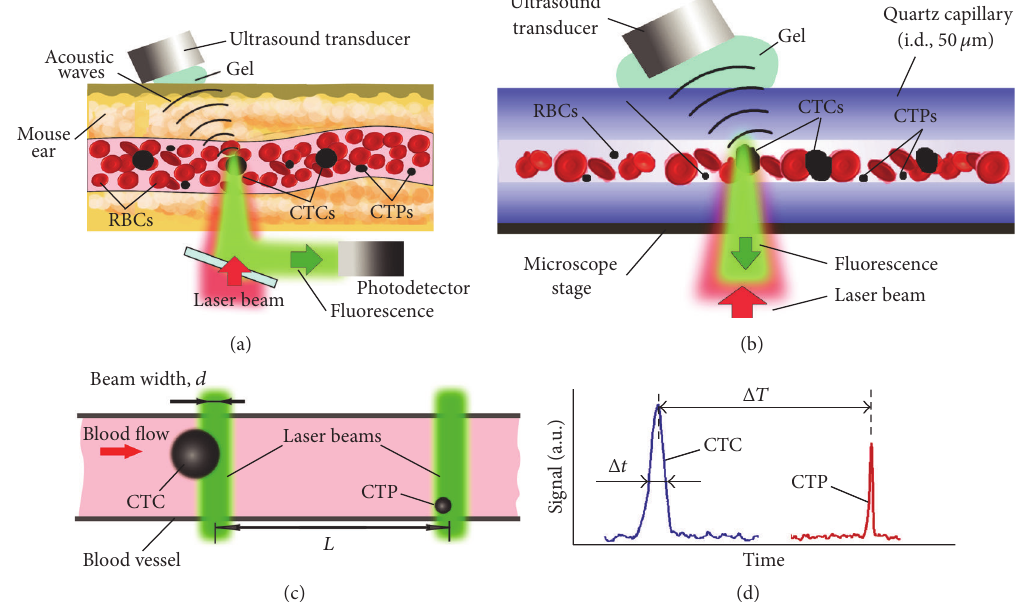
Figure 1: Photoacoustic and fluorescent flow cytometry platform. (a) The principle of in vivo detection of CTCs and CTPs using integrated PAFFC schematic. (b) The in vitro schematic for detection of CTCs and CTPs in a capillary tube using PAFC. (c) Two-beam time-of-flight schematic. (d) Signal diagram for CTC and CTP identification in two-beam time-of-flight